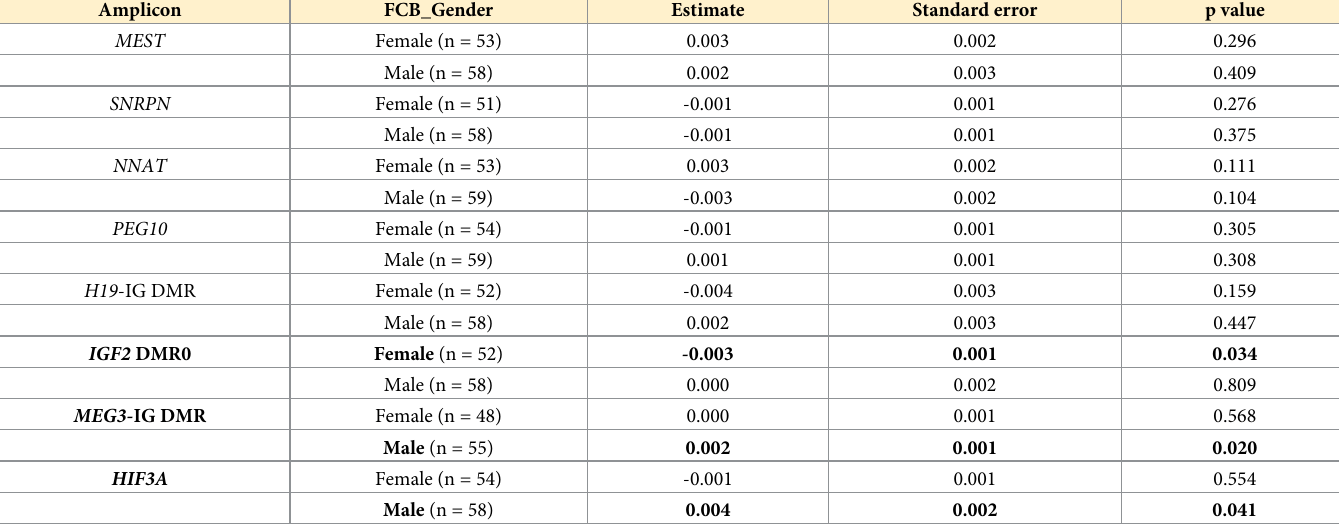
confounding factors. Because of limited amounts of DNA, we analyzed 111 cord blood samples for MEST , 109 for SNRPN , 112 for NNAT , 113 for PEG10 , 110 for H19-IG DMR , 110 for IGF2 DMR0 , 103 for MEG3-IG DMR, and 112 for HIF3A . Interestingly, the influence of father’s BMI on the FCB DNA methylation varied depending on the gender of the child. Here, MEG3 - IG DMR (regression estimate +0.002, P = 0.020) and HIF3A (regression estimate +0.004, P = 0.041) cord blood DNA methylation of males but not females showed a positive correlation with the BMI of the father. In addition, IGF2 DMR0 (regression estimate -0.003, P = 0.034) showed a negative correlation with paternal BMI in female FCBs (Table 3 and Fig 1). However, none of the correlated genes survived multiple testing adjustment. It is noteworthy to mention (Table 4). In additional S1 File, we present statistics without adjusting to any confounding fac- tors. We additionally tested the extent to which DNA methylation in sperm correlates with cord blood methylation (additional S2 File). Here, the MEG3-IG DMR revealed the strongest correlation (p-value = 0.070) between methylation values across both studied tissues. Table 3. Multivariable regression analysis using linear models: Fetal cord blood DNA methylation in relation to paternal body mass index. Amplicon FCB_Gender Estimate Standard error